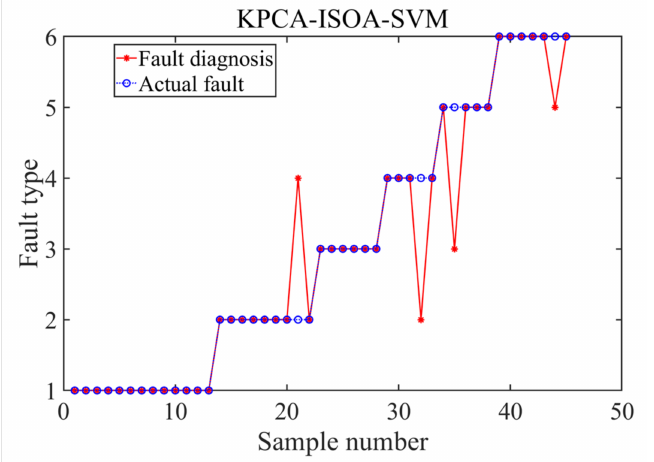
Figure 9. Diagnosis results.